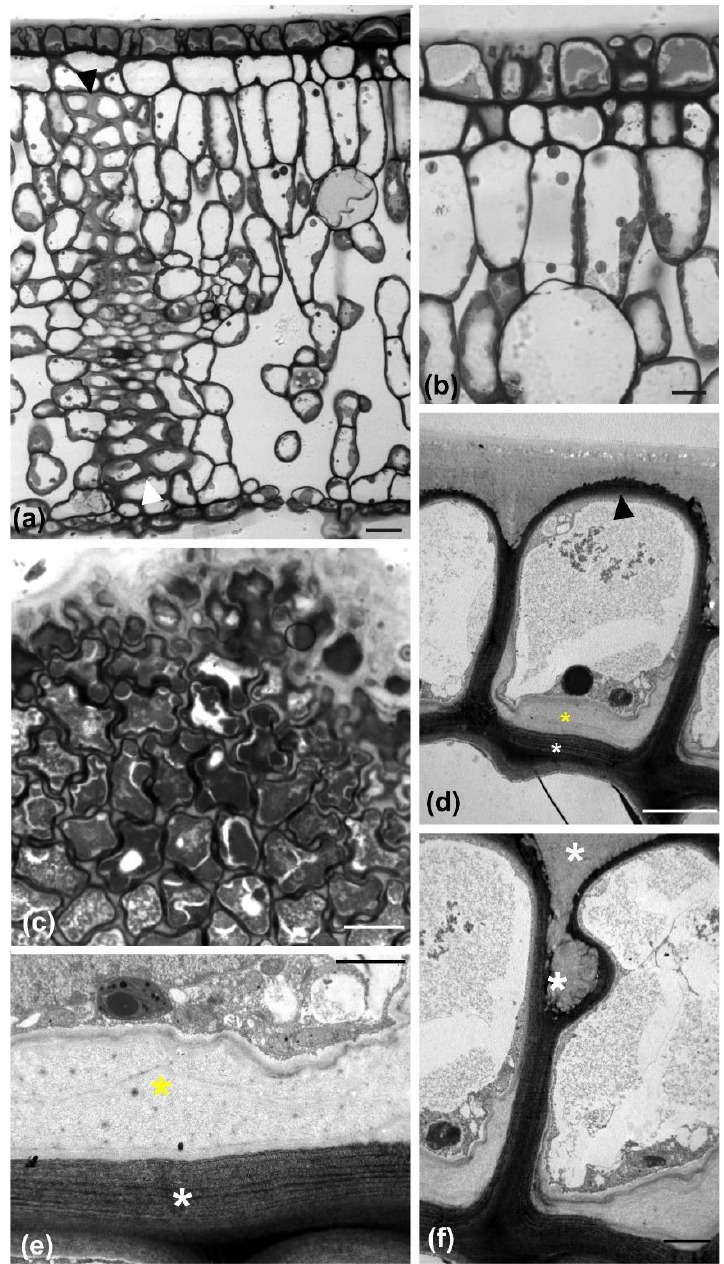
Figure 7. Light ( a – c ) and TEM ( d – f ) micrographs of mature leaves at transverse ( a , b , d – f ) or paradermal ( c ) section. At low magnification of transverse section ( a ), a “wall” of sclerenchyma cells can be observed (arrowheads) extending between the adaxial and abaxial epidermides. In addition, the external adaxial epidermal cells appear partially detached, which is shown at higher magnification in ( b ). The detachment is also visible at grazing paradermal section ( c ). ( d ) At TEM level, external adaxial epidermal cells exhibit a polylamellate inner periclinal wall (white asterisk), thicker than the external periclinal one (arrowhead), lined by the deposition of polysaccharide material (yellow asterisk). ( e ) Higher magnification of an inner periclinal wall area, like that in ( d ), with same labeling. ( f ) Higher magnification of a detachment site between two adjacent adaxial epidermal cells, depicting the stuffing with cuticle material (asterisks). Scale bars a: 20 µ m, b, d: 5 µ m, c: 10 µ m e, f: 2 µ